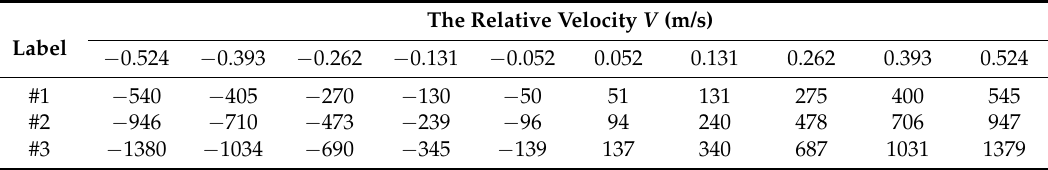
Table 1. The values of the damping force F c.